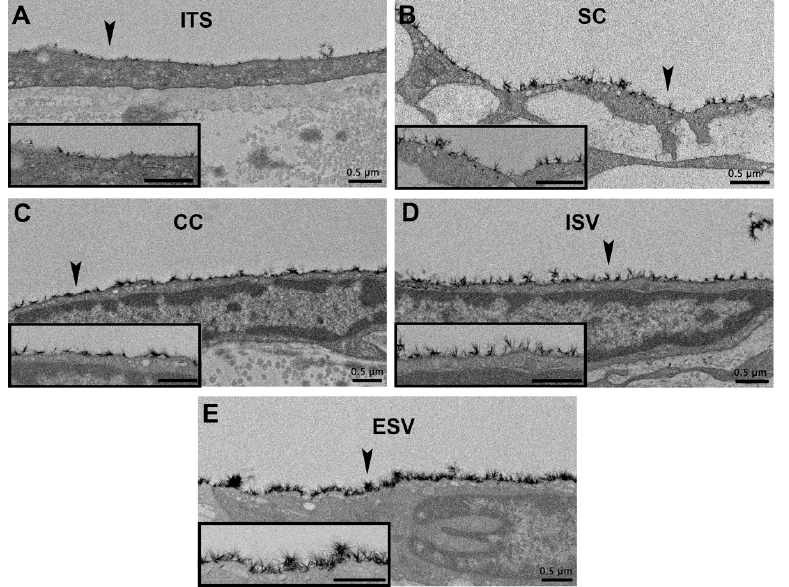
Figure 3. Glycocalyx coverage along the different locations of the outflow pathway in control eyes and non-lasered regions of laser-treated eyes. ( A – C ): Glycocalyx coverage did not differ signifi- cantly between outflow pathway locations in undetermined-flow type (ANOVA, F = 0.42, p = 0.86), and high-flow regions (ANOVA, F = 1.42, p = 0.21) of control eyes. While coverage was significantly different across all outflow locations within low-flow regions of the control eyes (ANOVA, F = 2.24, p = 0.04), no significant differences were noted for any pairwise comparison of locations. ( D ): Non-lasered regions of the laser-treated eyes displayed a significant increasing trend in glycocalyx coverage proximally to distally along the conventional outflow pathway (ANOVA, F = 11.57, p ≤ 0.01). Error bars: SEM. * p < 0.05, ** p ≤ 0.01.